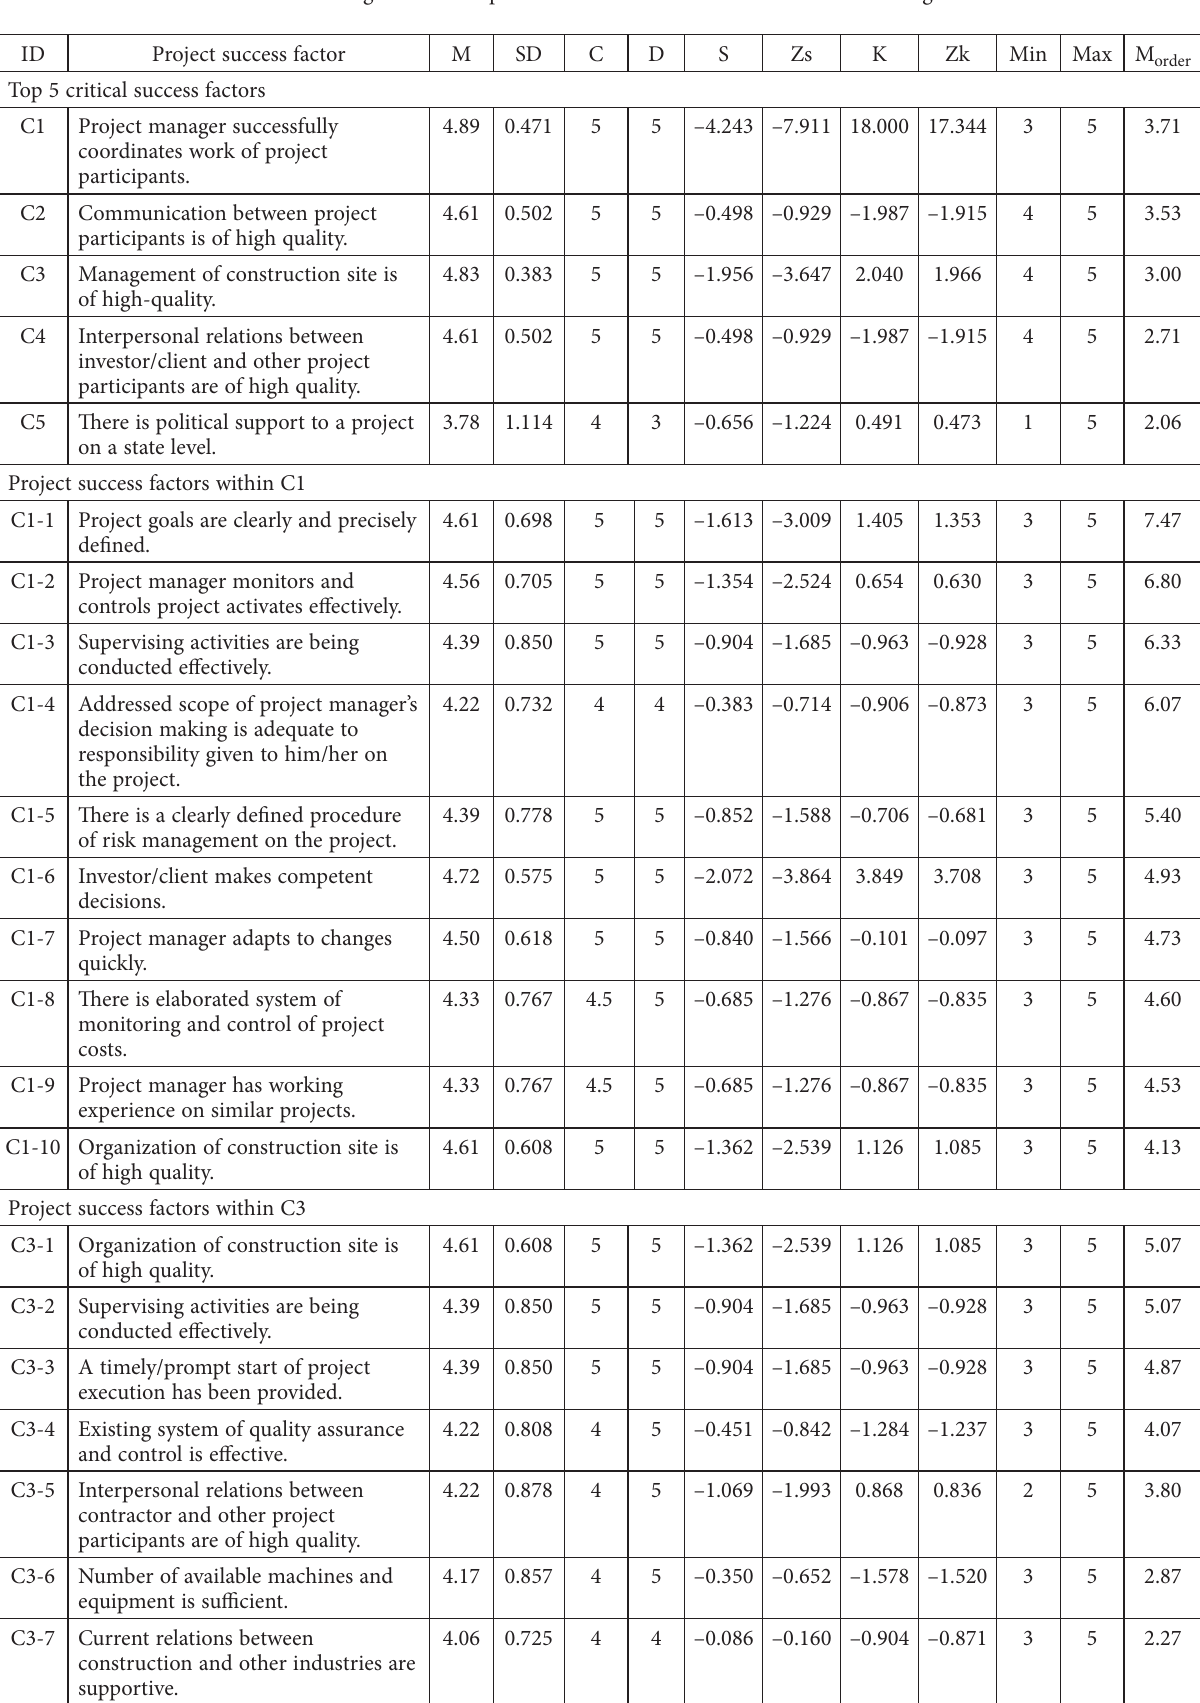
Table 9. Results of testing of variables placement and order within critical factors’ categories in